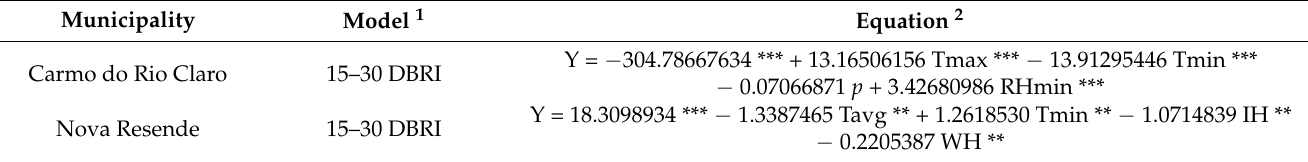
Table 5. Estimated parameters of the adjusted models for the Carmo do Rio Claro and Nova Resende municipalities, Minas Gerais state,